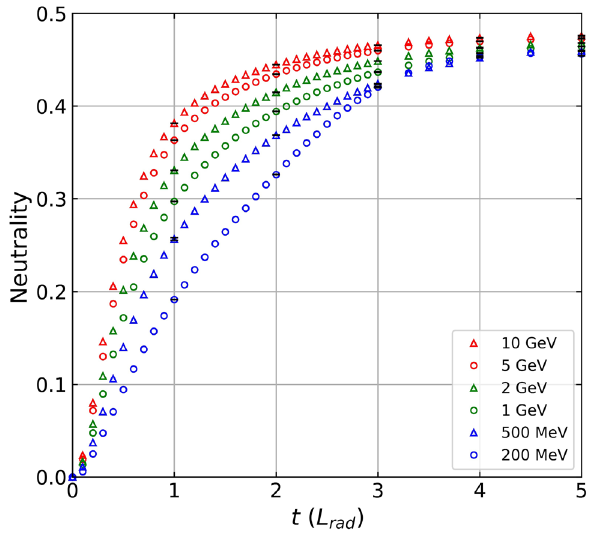
Figure 5. Charge neutralities of electron–positron beams, N e + /( N e − + N e + ) , are shown as functions of the